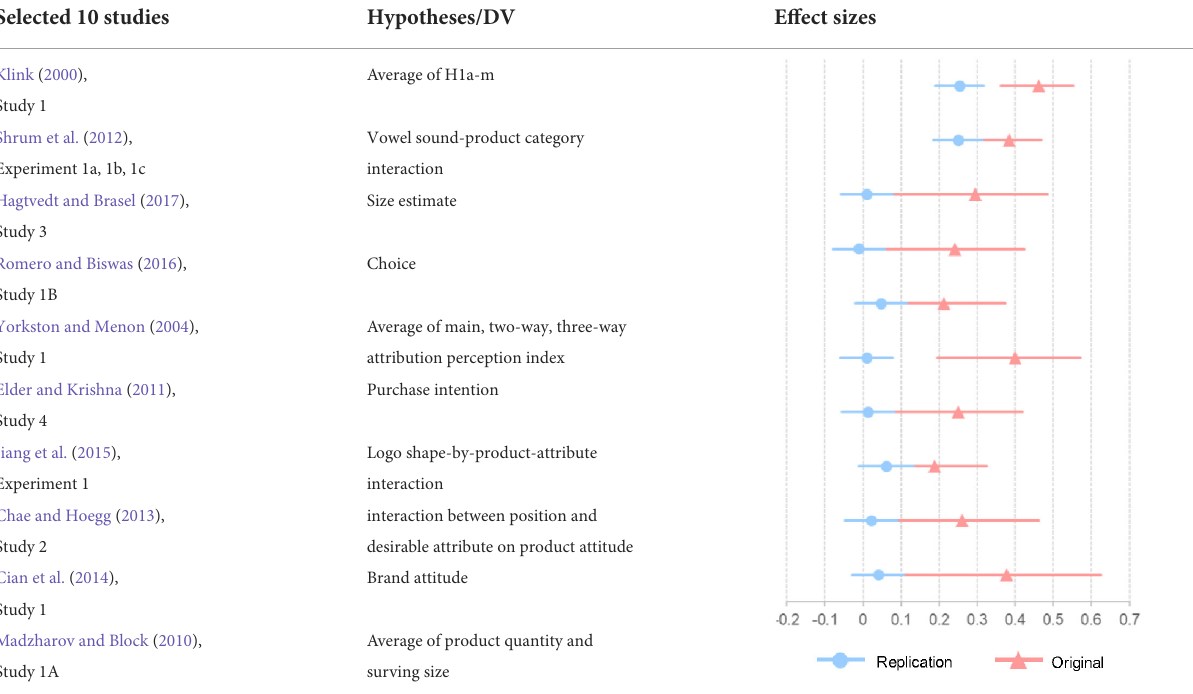
TABLE 4 Main findings of selected 10